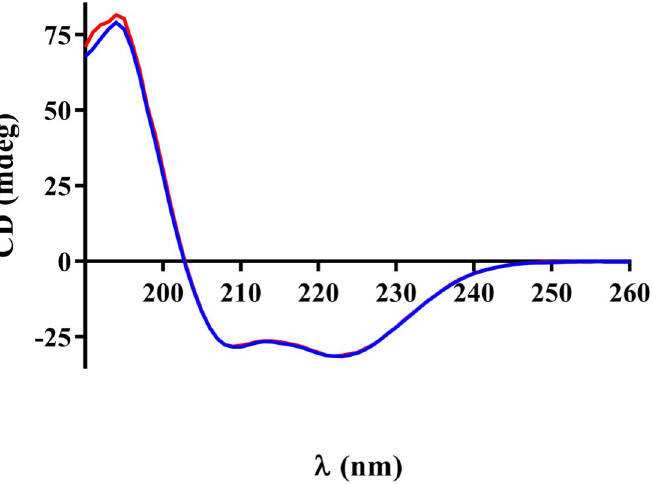
Fig 4. The p58C 272-464 and p58C 266-464 constructs have the same distribution of secondary structures in solution. CD spectra p58C 272-464 (blue) and p58C 266-464 (red) were collected at room temperature for a solution containing 0.3 mg/mL of protein in a buffer containing 20 mM K 2 HPO 4 (pH 7.0). DNA binding properties of the two constructs. We first used a fluorescence intensity (FI)- based assay with an RNA-primed DNA substrate composed of a Cy5-labelled 18 nt DNA tem- plate strand annealed with a complementary 5’-triphosphorylated 8 nt RNA primer, corre- sponding to a high affinity product produced by primase [36]. The affinities of p58C p58C for this substrate were measured by monitoring initial fluorescence intensity (FI) 266-464 changes as p58C was titrated into a fluorescently-labelled substrate (Fig 6). Fitting these data to a single site binding equation returned dissociation constants (K